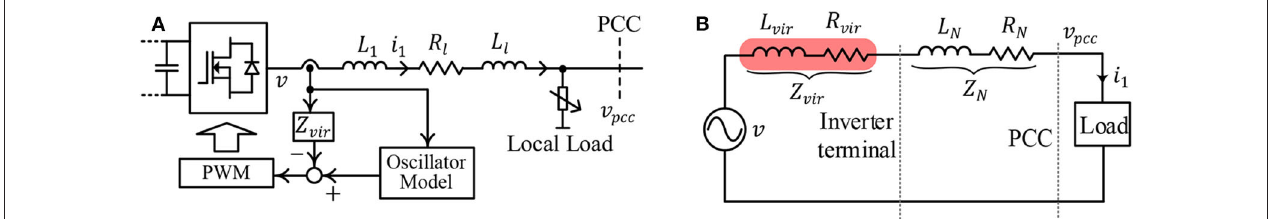
FIGURE 15 | System of an islanded GFM converter: (A) system diagram, (B) voltage harmonics